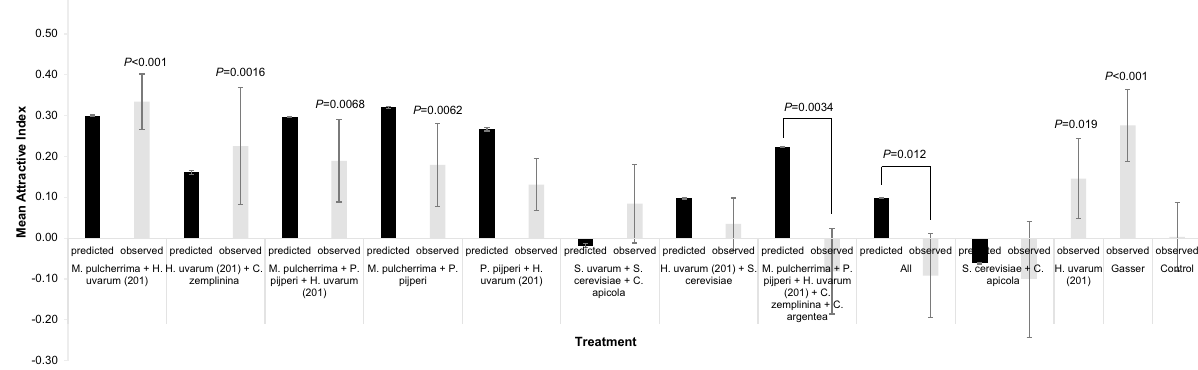
Figure 4. Mean (± SE) Attraction Index (AI) of D. suzukii to combinations of yeast metabolic volatiles (not identified) after growth in strawberry juice and then mixed in equal proportions, using laboratory T-mazes. H. uvarum (201), sterile fruit and commercial Gasser-lure act are controls. N = 6–7 for all treatments. Grey bars represent observed AI and black bars predicted AIs calculated from 10,000 permuted in silico mixes of corresponding individual AI values. The observed AIs of two combinations is significantly different from that predicted and are shown with solid connecting lines. P-values above bars show significance of attraction to yeast volatiles over sterile strawberry juice in the opposing T-maze arm revealed by binomial